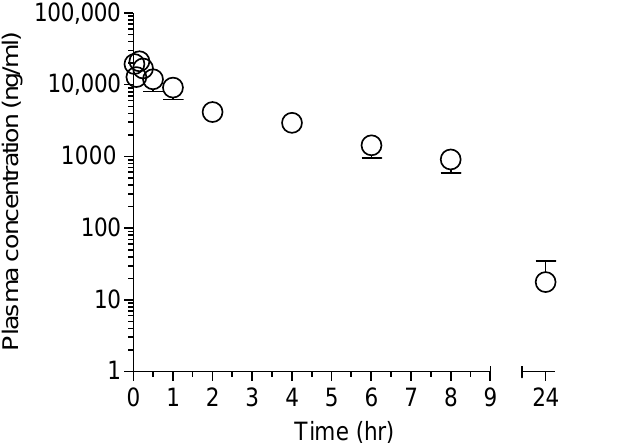
Figure 2. Plasma concentration-time profiles of APA following a single intravenous dose of APA in male ICR mice. A single dose of APA (5 mg/kg; n = 5) was given intravenously and the plasma concentration of APA ( ○ ) was determined for 24 hr post-dosing. Each point represents mean ± S.D. ( n = 5). Table 2. Pharmacokinetic parameters obtained following a single intravenous dose of APA in mice. Parameter